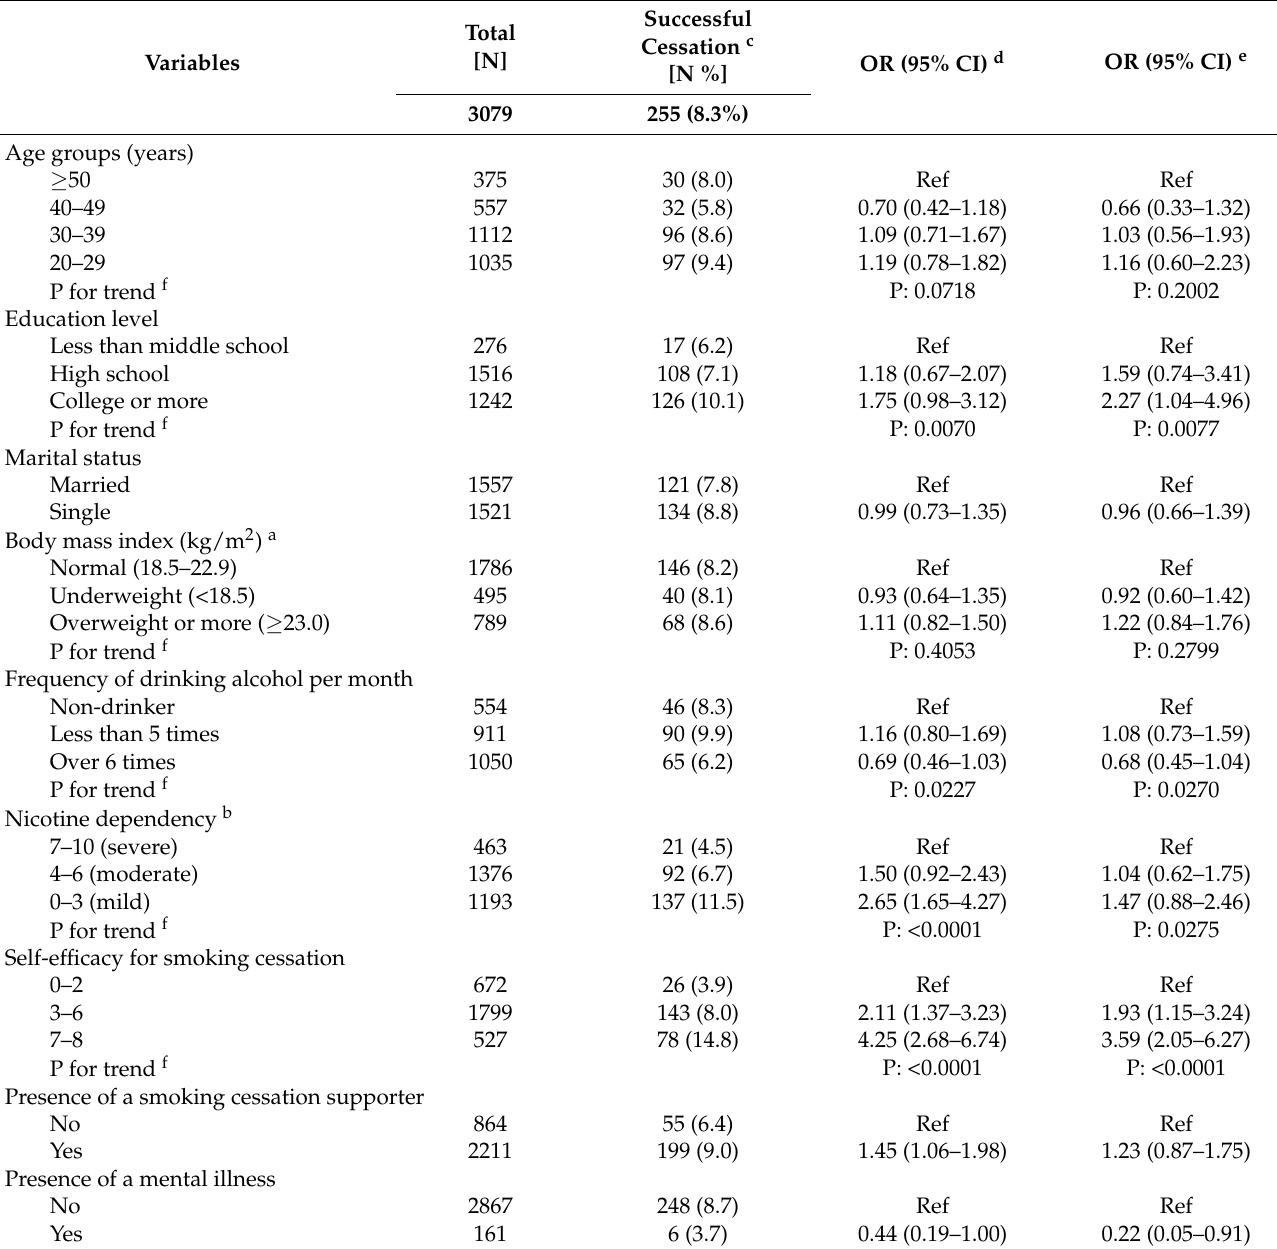
Table 3. Odds ratio and 95% confidence intervals of potential factors associated with smoking cessation at the 1-year